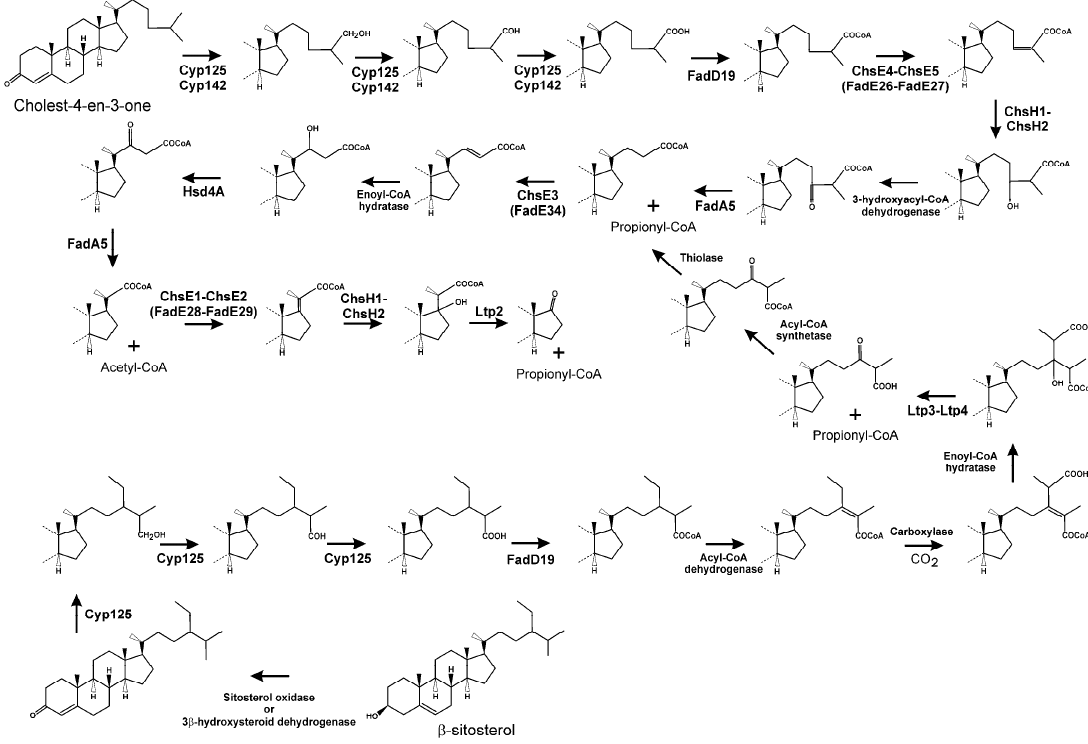
Figure 5. Catabolism of the cholesterol side chain and C 24 -branched chain of β -sitosterol in Actinobacteria.